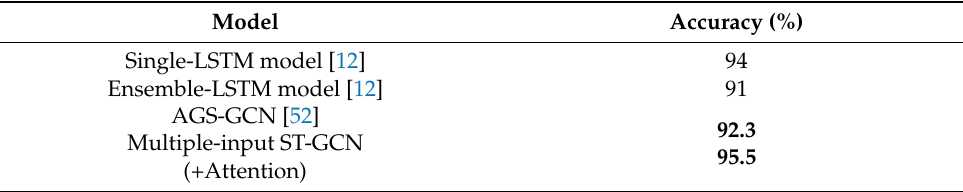
Table 5. Comparison of performance of the proposed method with the schemes in the literature for MMGS